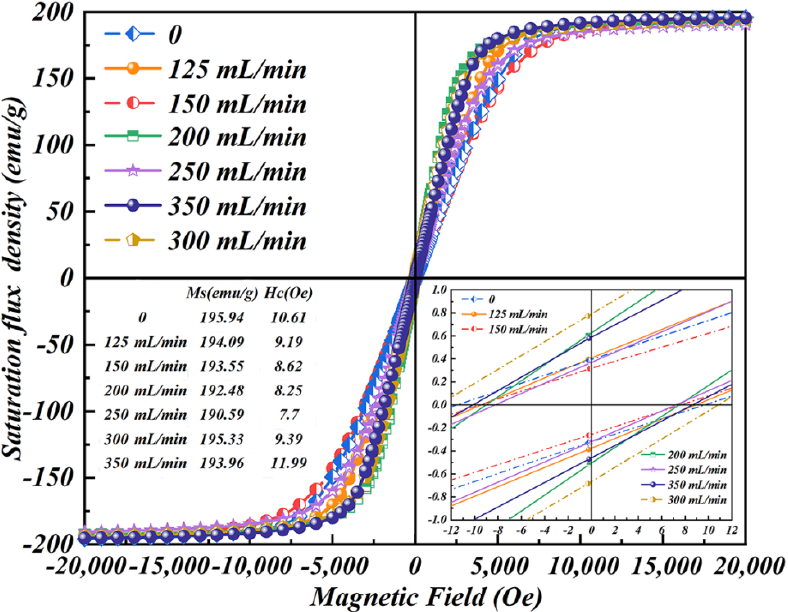
Figure 6. Magnetic hysteresis and partial enlarged curves of Fe–Si compacts and Fe–Si/SiO 2 soft magnetic composites at different Ar-dilution gas flow rates.